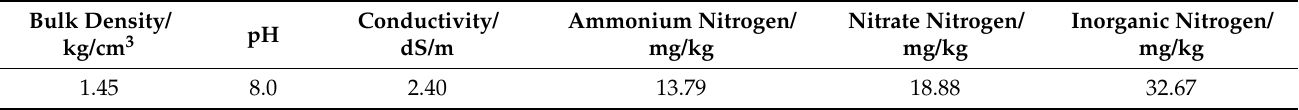
Table 1. Physical and chemical properties of the saline soil.